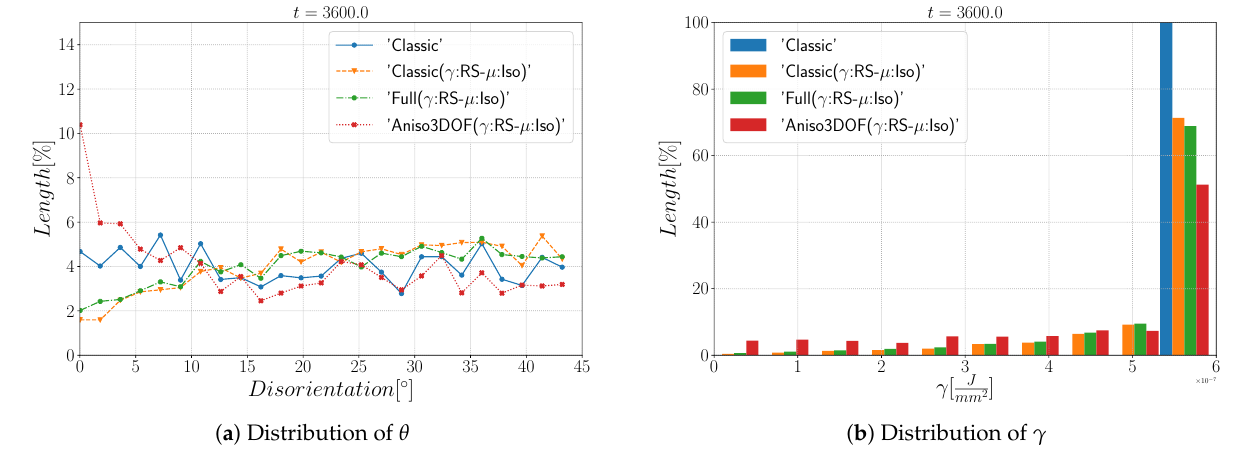
Figure A11. Grain boundary characteristics’ distributions at t = 1 h